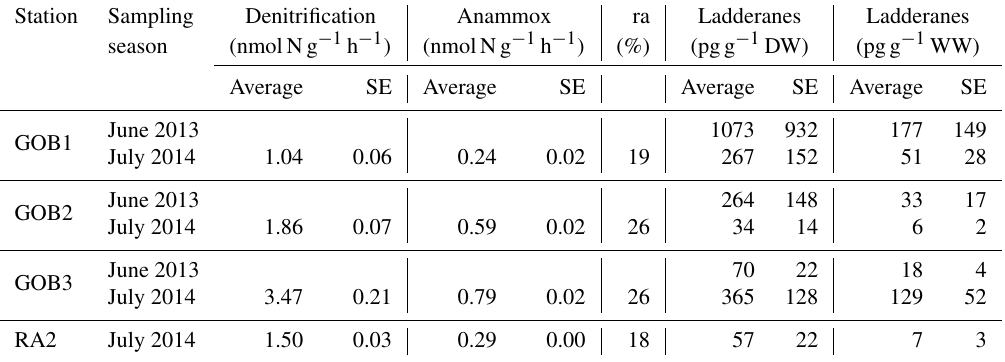
Table 2. Average rates of potential denitrification and anammox from anoxic slurry incubation expressed per gram of wet sediment with associated standard error (SE, n = 15). Values of ra, and average abundances of PC-monoether ladderanes in the top 4cm of sediment with associated SE ( n = 4). DW is sediment dry weight, and WW is sediment wet weight.